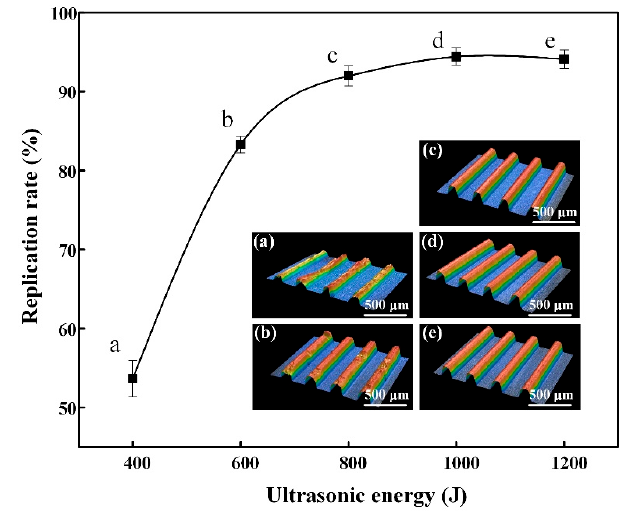
Figure 5. The replication rate of micro-structure at different ultrasonic energies and three-dimensional profile: ( a ) 400 J; ( b ) 600 J; ( c ) 800 J; ( d ) 1000 J; ( e ) 1200 J. Table 2. Replication rate and surface roughness of micro-structured part fabricated under di ff erent ultrasonic